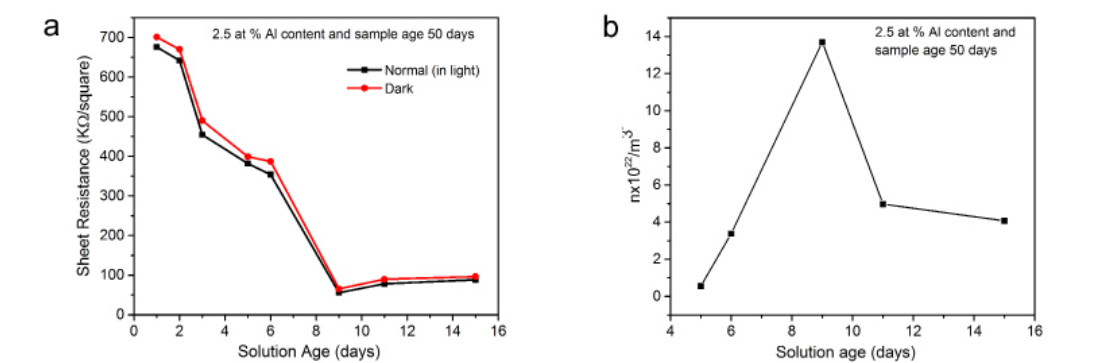
Fig. 2 (a) Effect of ageing time of starting solution on electrical sheet resistance of ZnO:Al thin films, (b) Effect of ageing time of starting solution on carrier concentrations of ZnO:Al thin